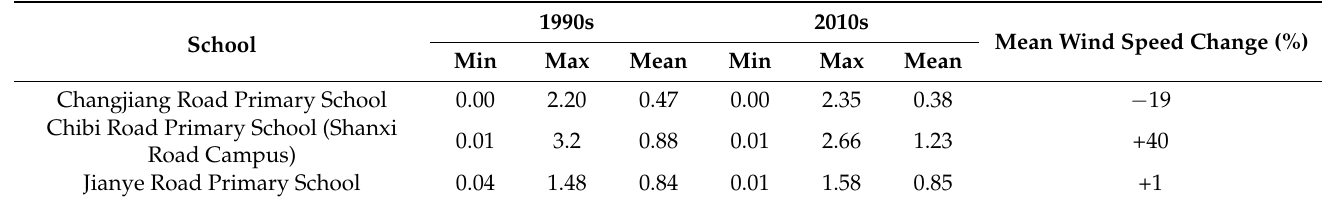
Table 3. Statistics of wind speed at pedestrian level in three primary schools in summer (m/s).